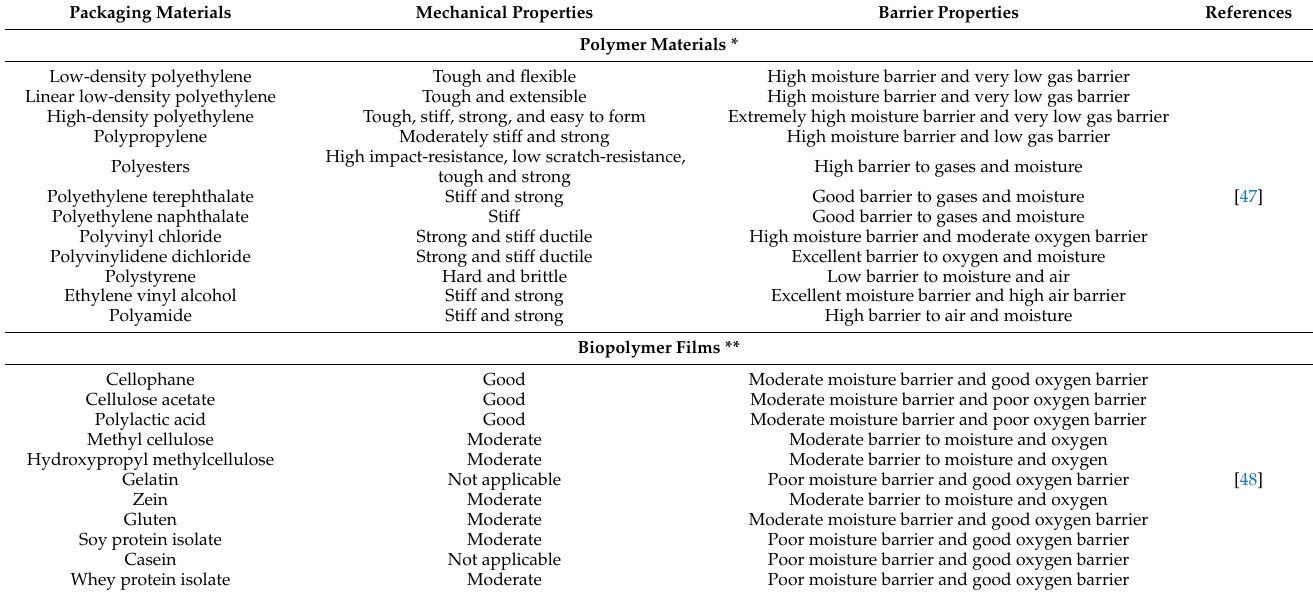
Table 2. General properties of polymers and biopolymers used in food